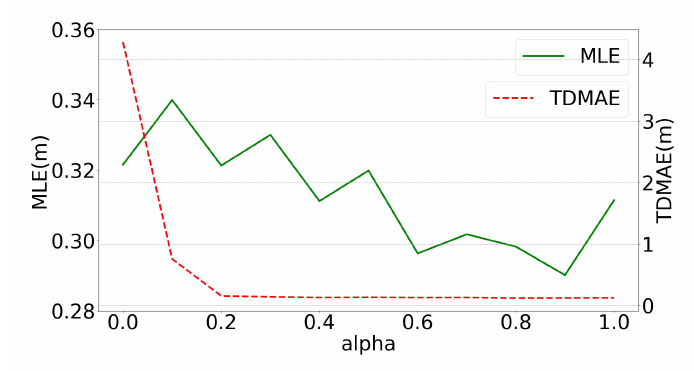
Figure 9. The MLE and TDMAE with the change in distance weight α